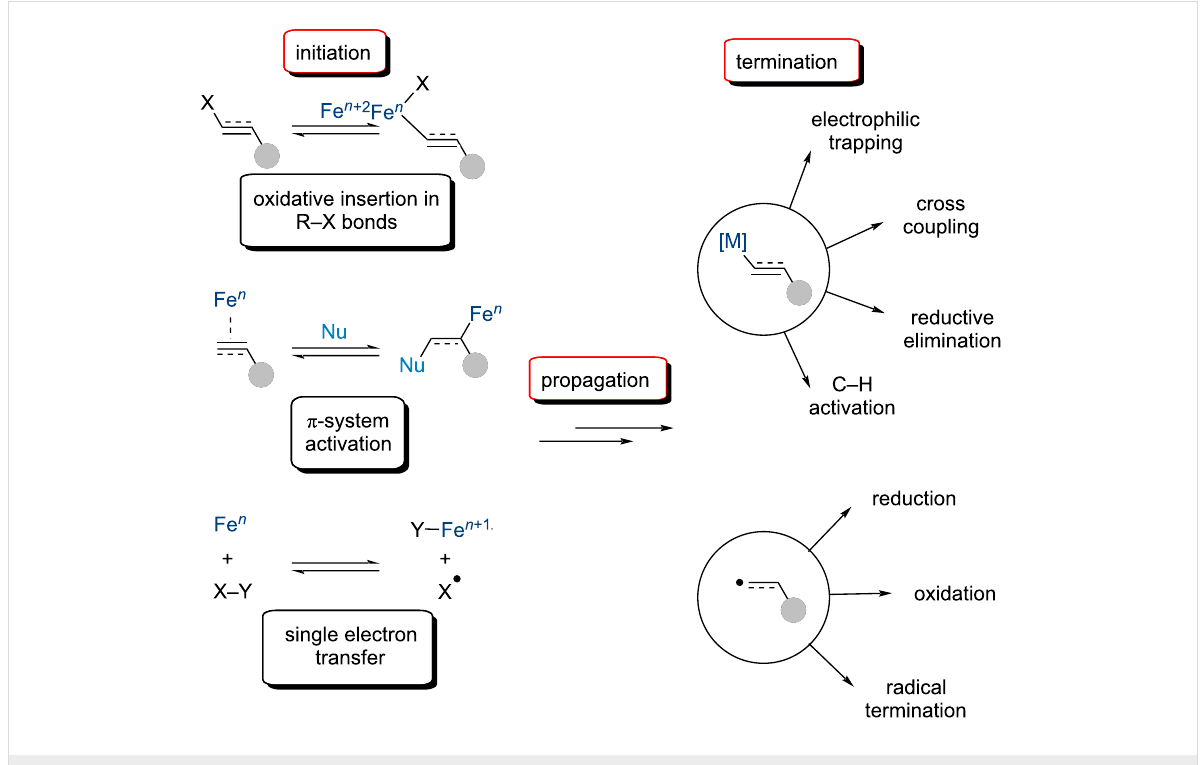
Scheme 2: The components of an iron-catalyzed domino